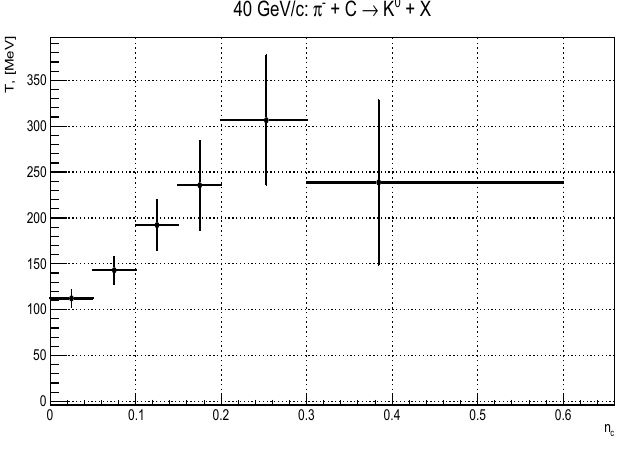
Figure 5. Temperature T as a function of n